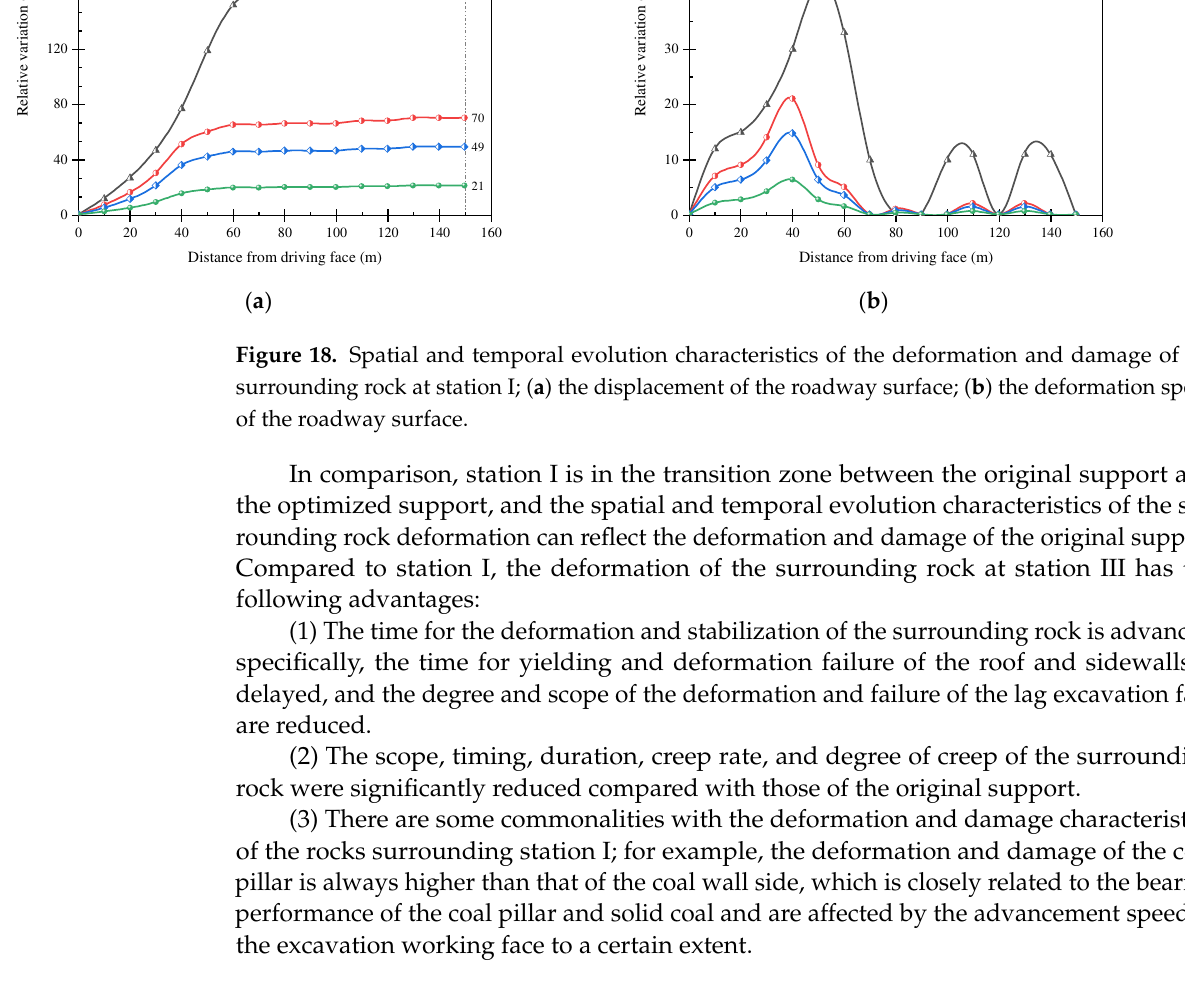
Figure 19. Spatial and temporal evolution characteristics of the deformation and damage of the surrounding rock at station III: ( a ) displacement of the roadway surface; ( b ) deformation speed of the roadway surface.